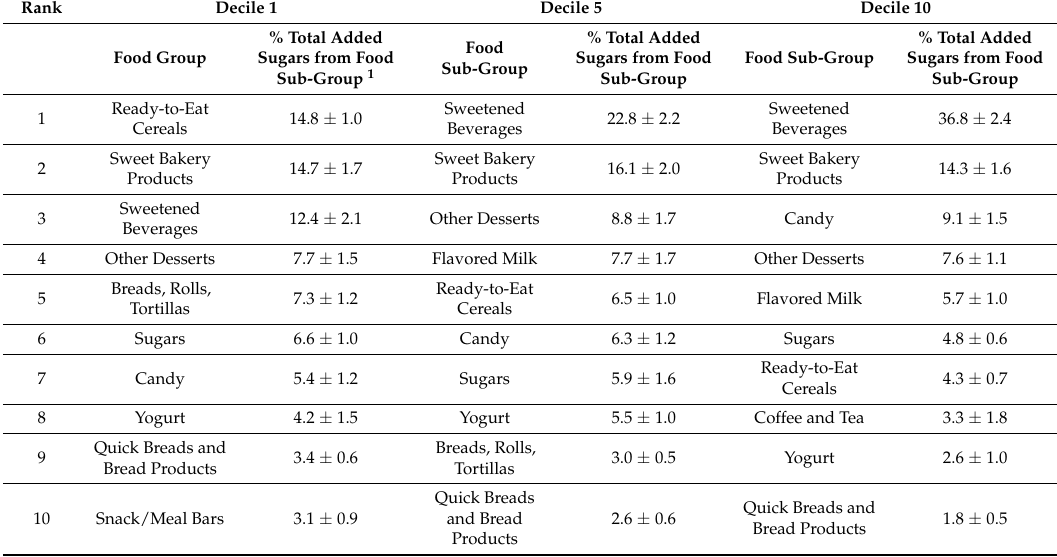
Table 3. Top ten food sources of added sugars for children 2–8 years by decile of intake, data from the National Health and Nutrition Survey, 2009–2012 ( n =